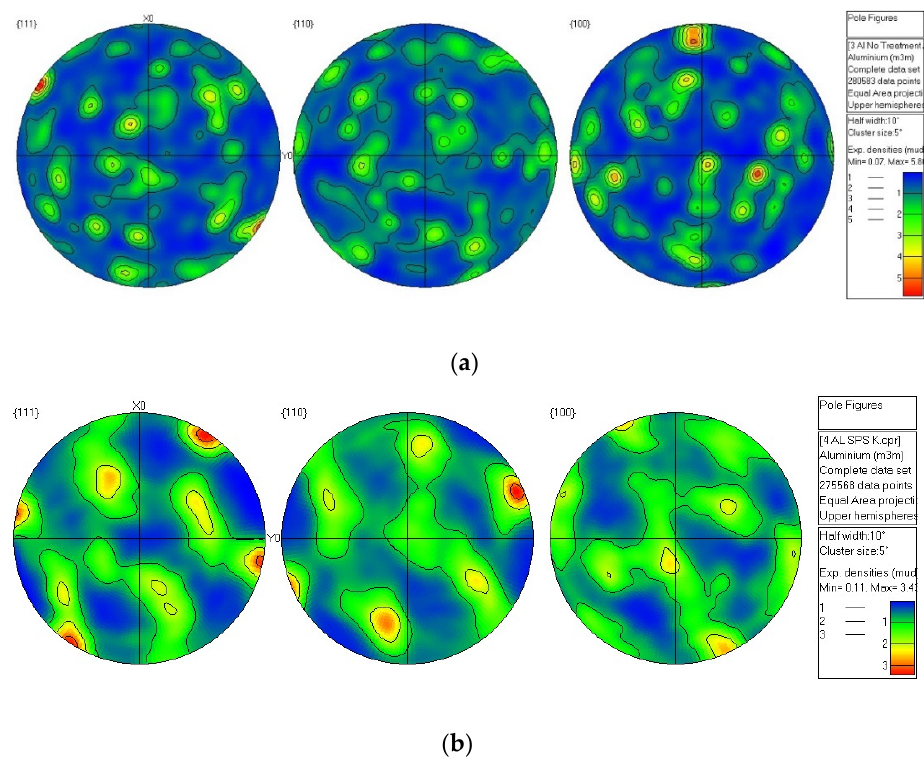
Figure 5. Maps of boundaries superimposed to image quality (IQ) images ( a , b ); grain size maps ( c , d ) of SPSed ( a , c ) and SPS-KOBO extruded ( b , d ) AA7075. Figure 6. Pole figures of SPSed ( a ) and SPS-KOBO extruded ( b ) AA7075.